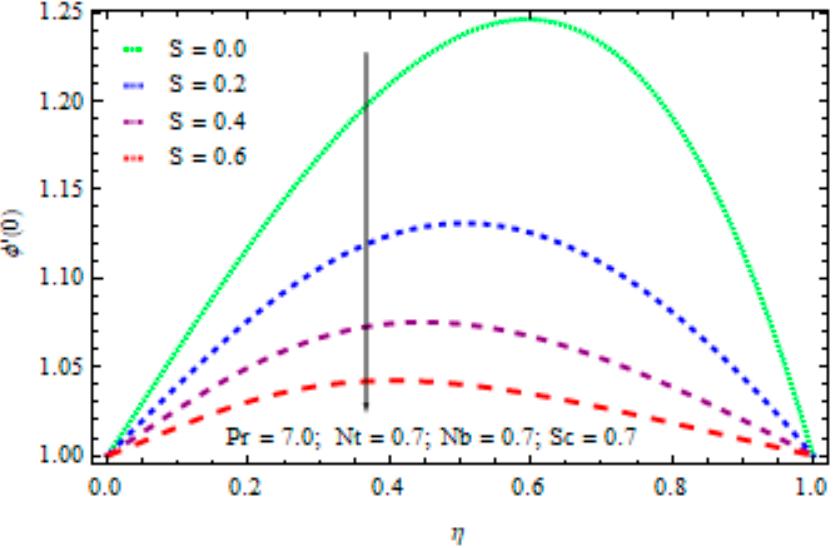
Figure 15. The impact of the unsteady parameter S on the heat transfer rate.